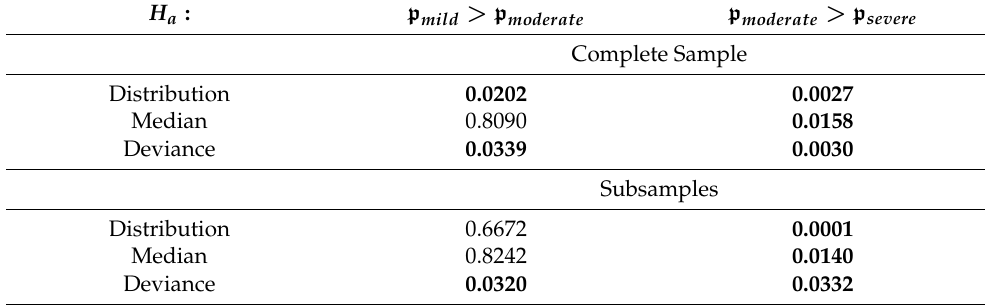
Table 4. p -values resulting from performing the permutation test on the depth to find distribution, median and deviance from the median differences. The top three rows refer to the tests performed on depth values computed with respect to the complete sample while the bottom three to tests performed on depth values computed for each of the three stages separately. Thus, Complete sample is for using the depth values of the pooled sample and Subsamples for using the depth values computed with respect to each sample separately. The alternative hypothesis for each test is greater than, but for the distribution case that coincides with the not equal alternative. p -values resulting in a rejection at 0.05 significance level are emphasized in